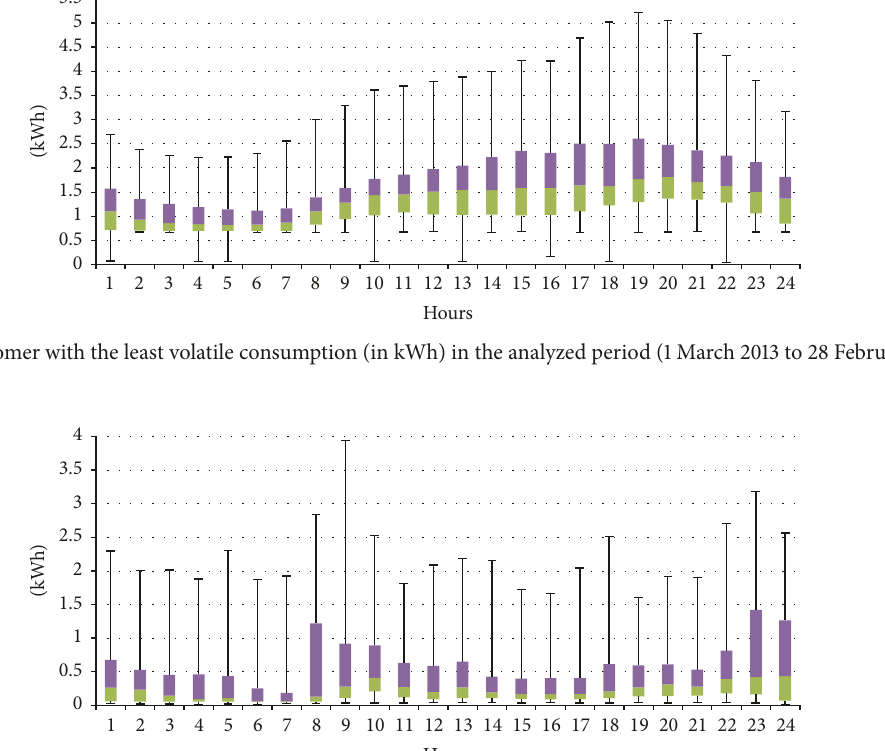
resulting dendrograms was then divided into the following groups by the cutree